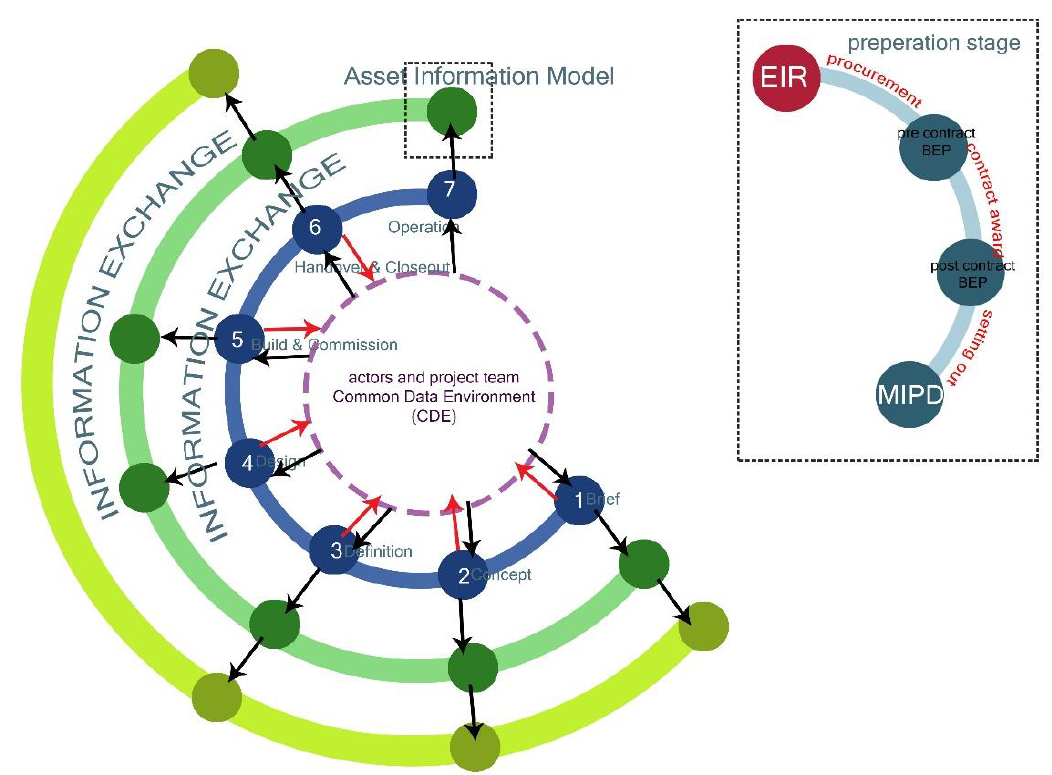
Figure 2. Layers of the BIM Information Delivery Lifecycle